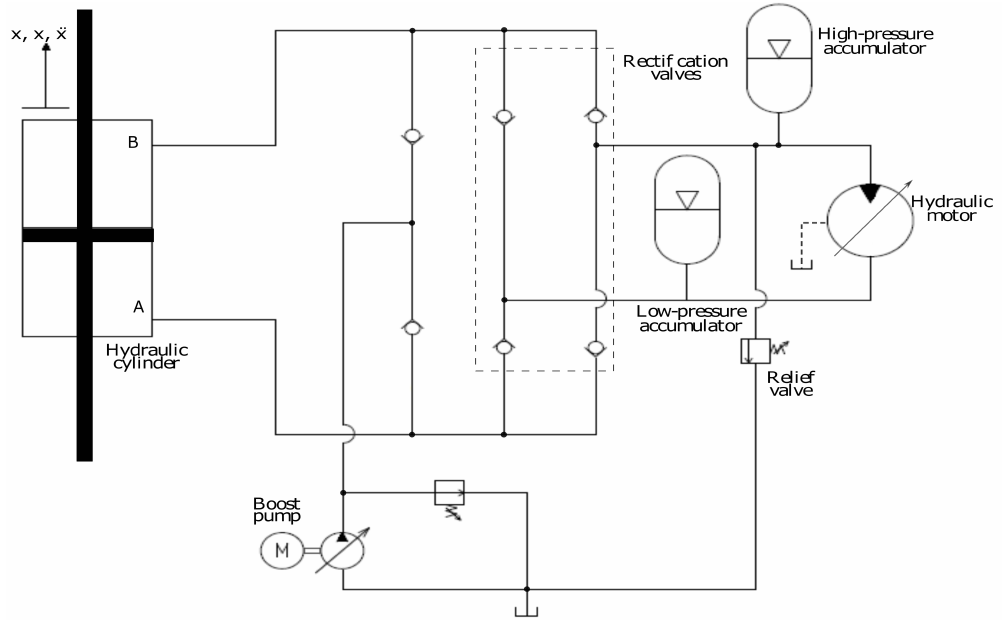
Figure 2. The scheme of a typical constant-pressure hydraulic transmission